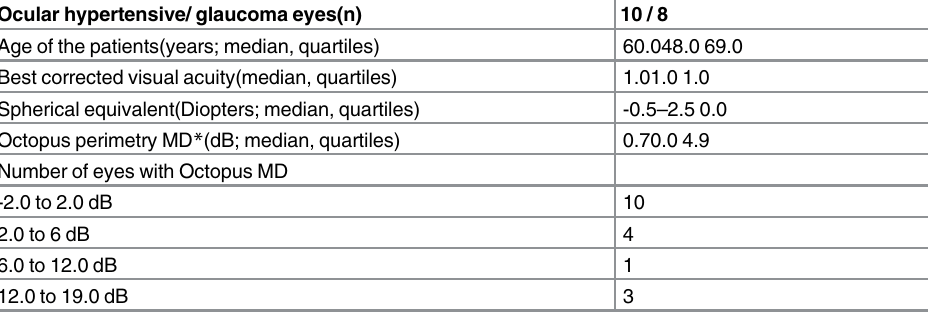
Table 1. Demographics of the study